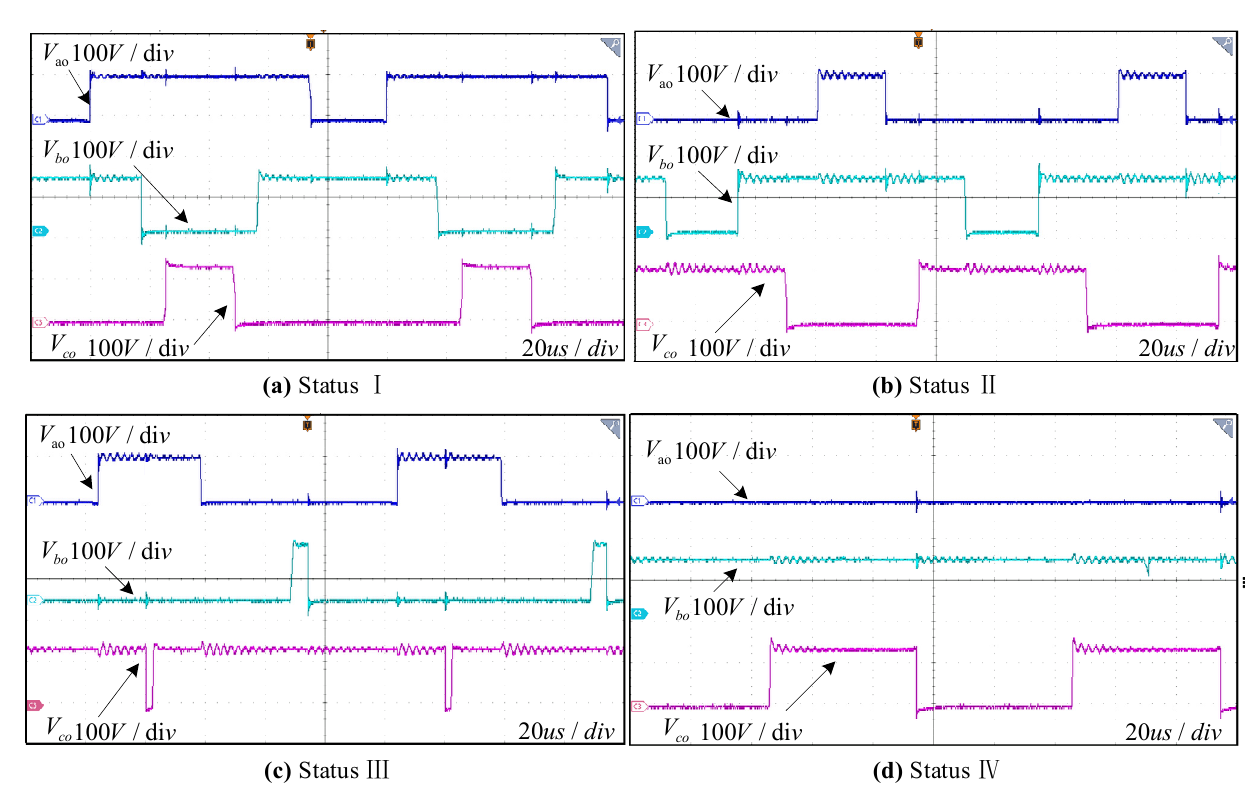
Figure 10. Three ‐ phase voltage waveform of AZSPWM d ifferent switching states .